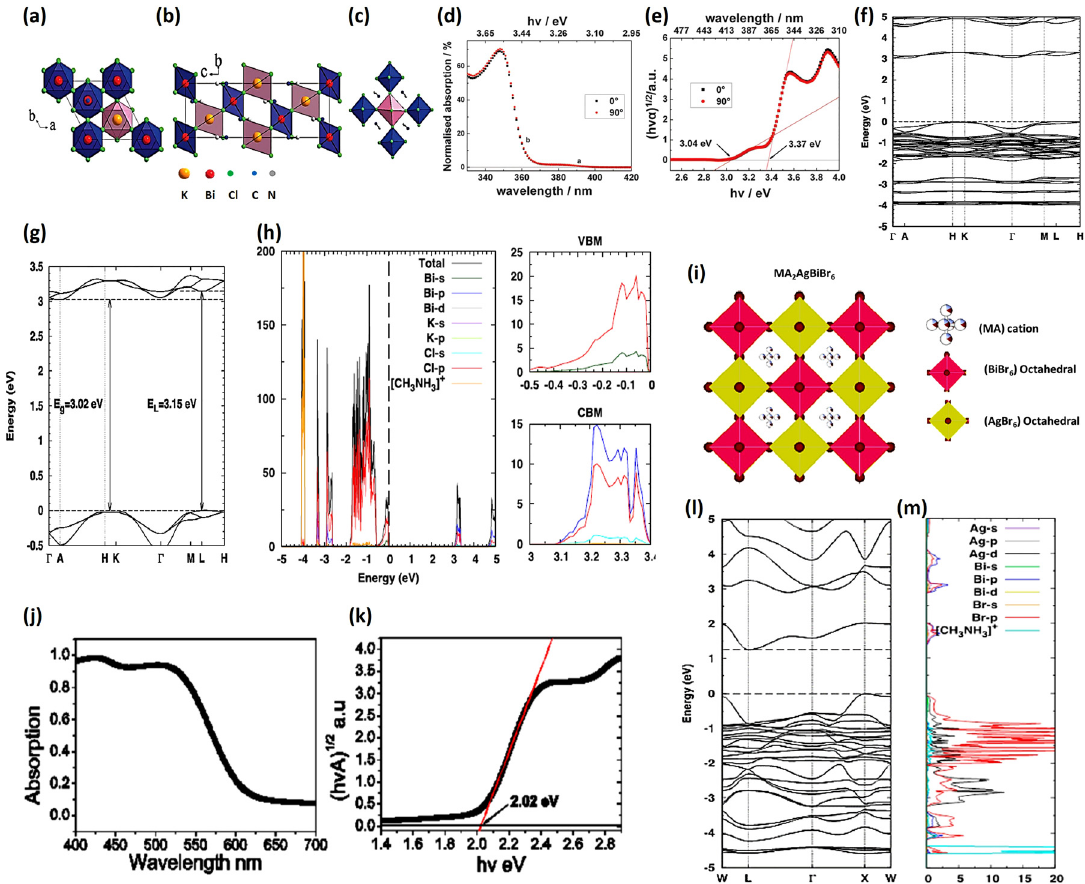
Figure 2: Crystal structure of MA 2 KBiCl 6 , along (a) the c -axis, (b) the a -axis and (c) tilted to show the MA location. (d) Absorption spectra and (e)theTaucplotofMA 2 KBiCl 6 [88].Copyright2015,RoyalSocietyofChemistry.(f)CalculatedbandstructureofMA 2 KBiCl 6 [88].Copyright2015, Royal Society of Chemistry. (g) Enlarged view of the band structure near the bandgap of MA 2 KBiCl 6 [88]. Copyright 2015, Royal Society